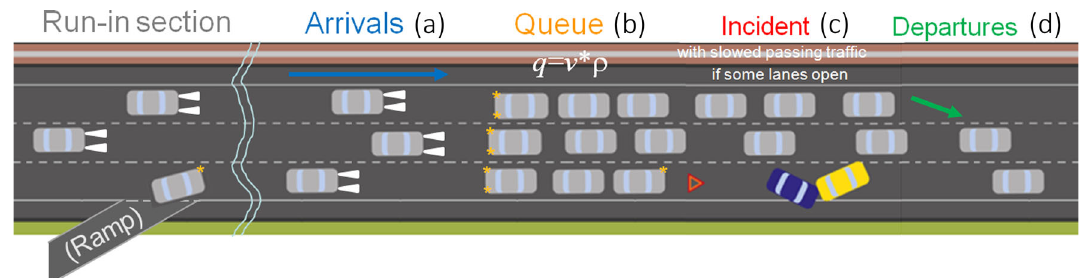
Fig. 2 Schematic system configuration for describing traffic states around an